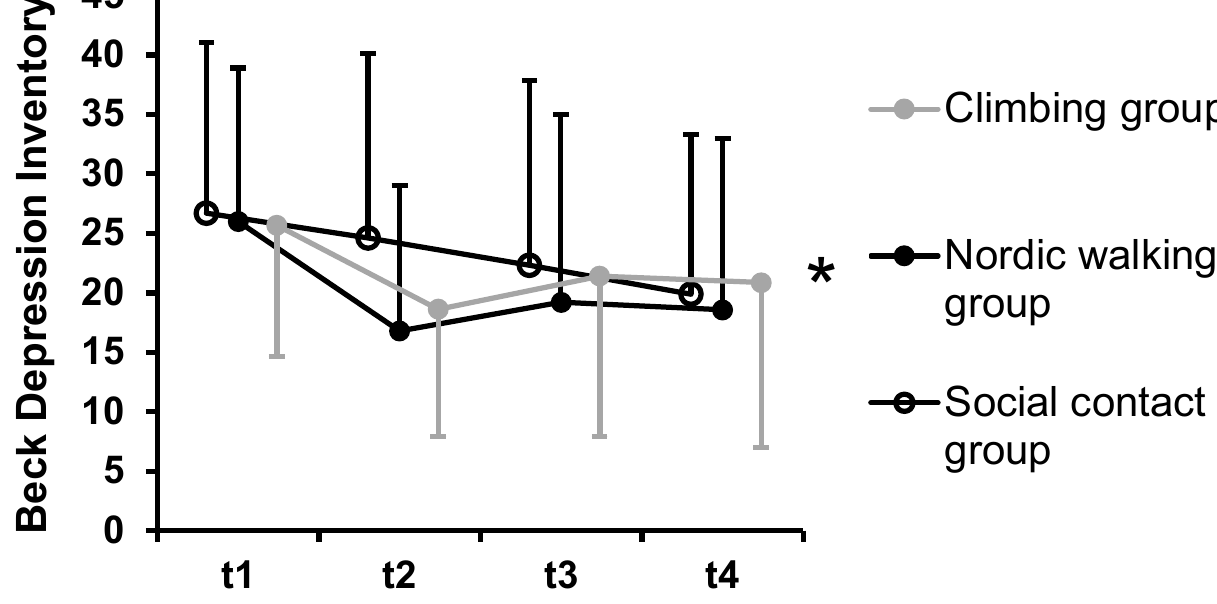
Figure 4. Symptoms of depression according to the Beck Depression Inventory by groups. Notes: * indicates a significant main effect of time. No significant group-by-time interaction emerged. Dots represent mean values; error bars indicate standard deviations. Table 2. Descriptive and inferential values of the psychological parameters of the group comparisons. Descriptives M (SD)